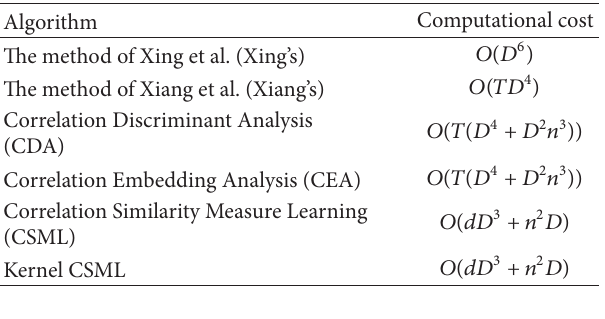
Table 1: Computational costs of related algorithms.